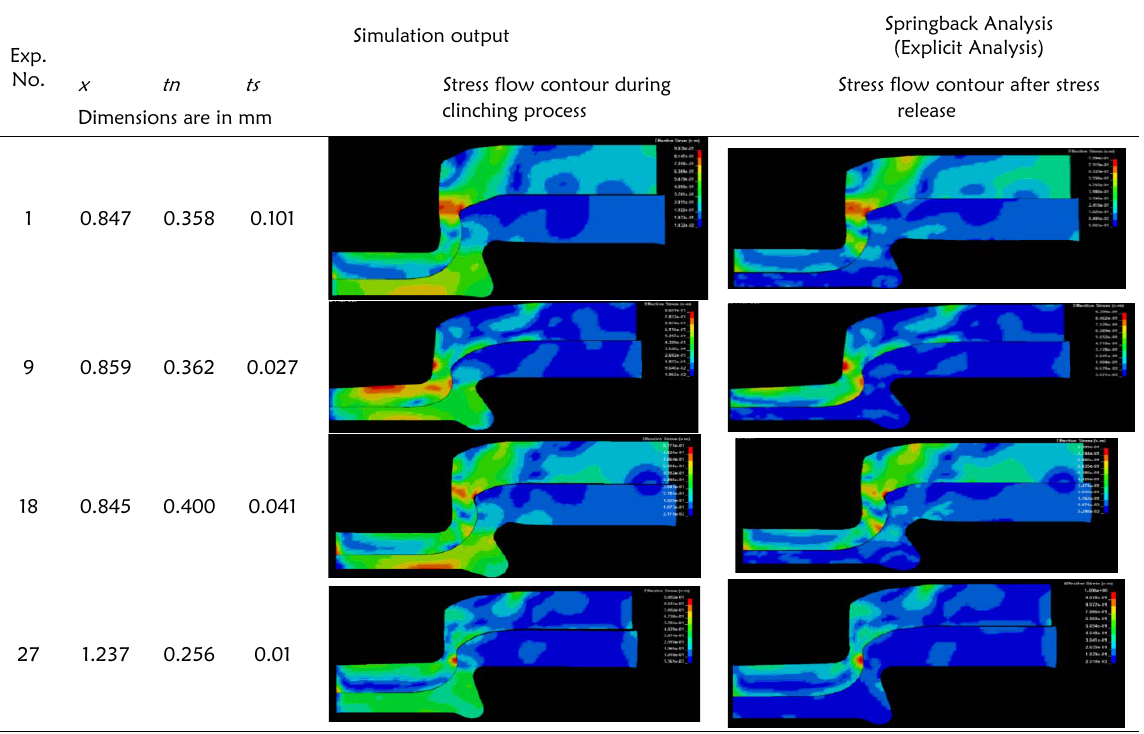
Table 1: Sample results of the orthogonal array L27 of the clinching simulation and springback.